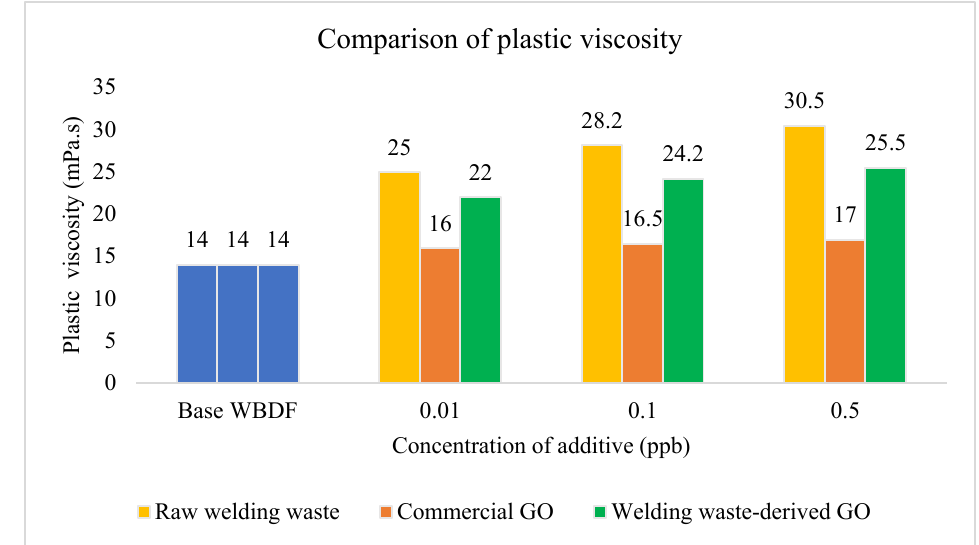
Figure 6. PV comparison of WBDF using different additives.